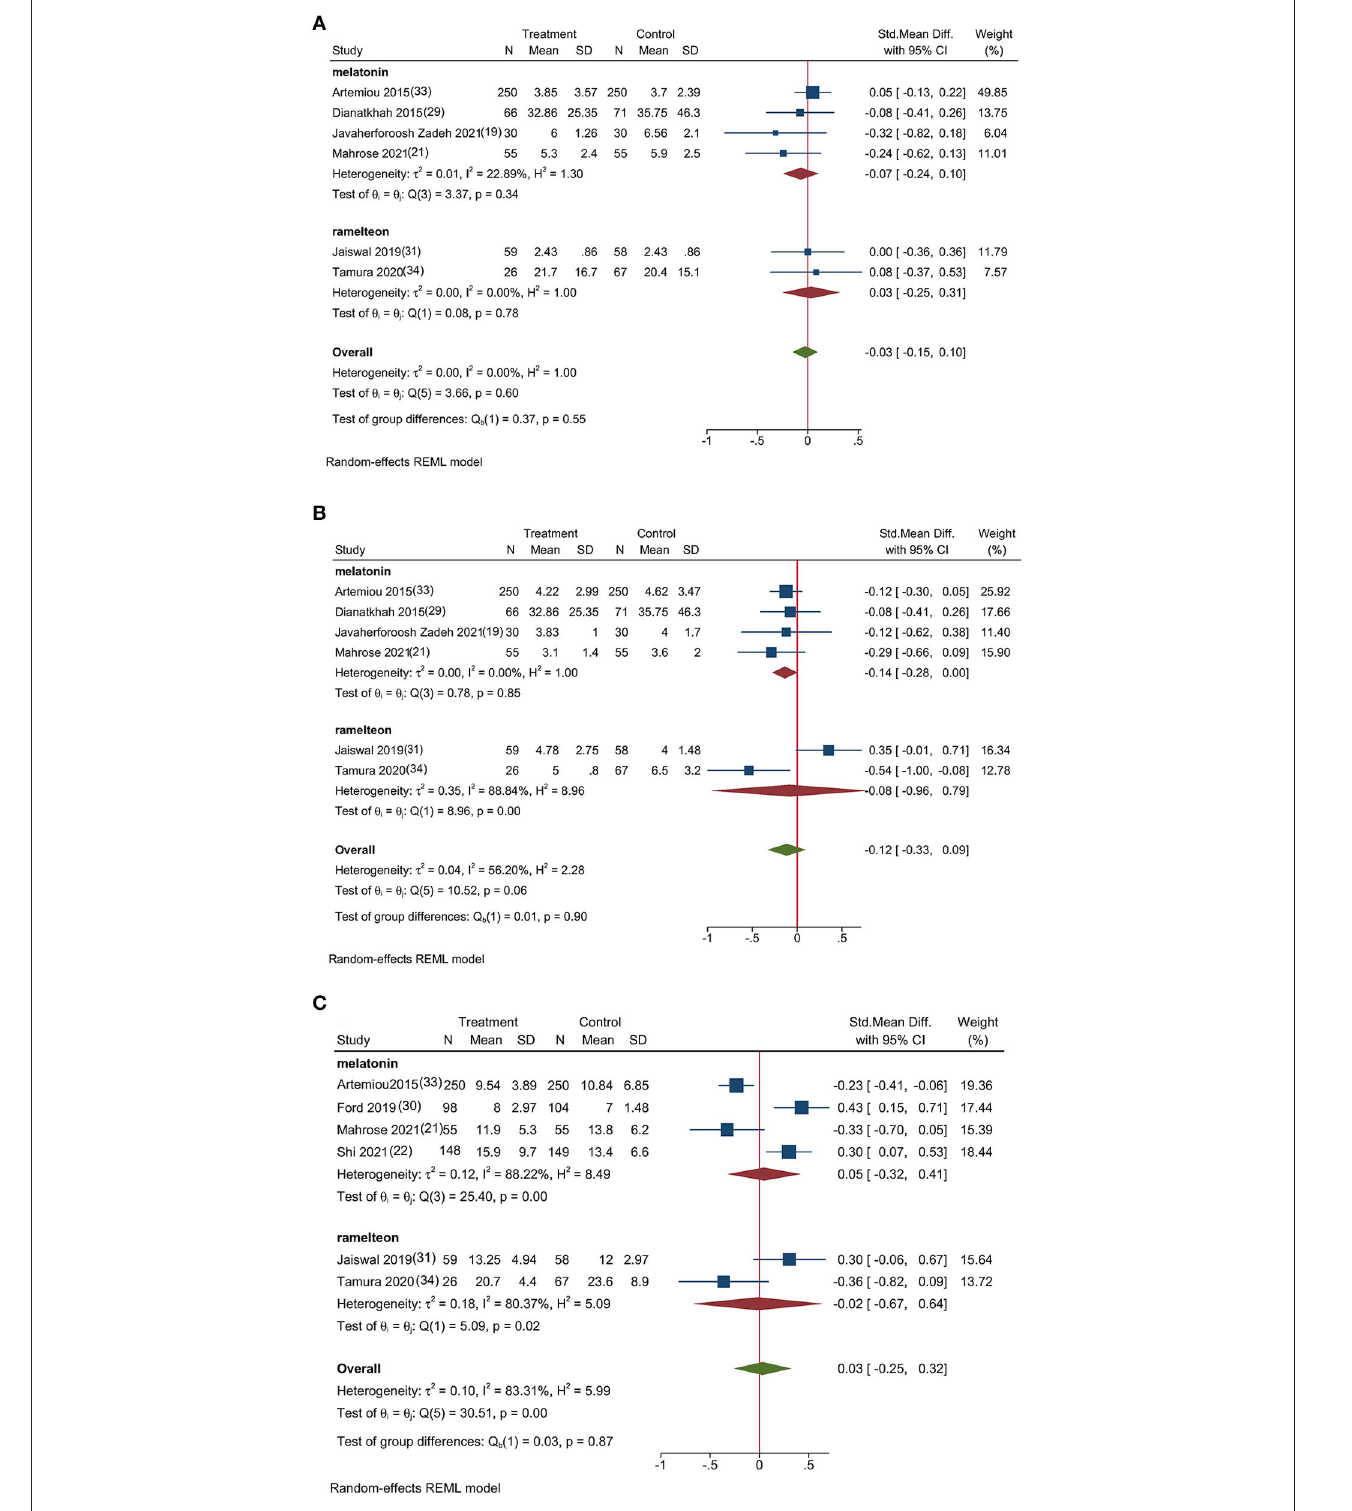
FIGURE 4 | Forest plot of the secondary outcomes; (A) Forest plot of the mechanical ventilation time, (B) Forest plot of the length of ICU stay, and (C) Forest plot of the length of hospitalization.